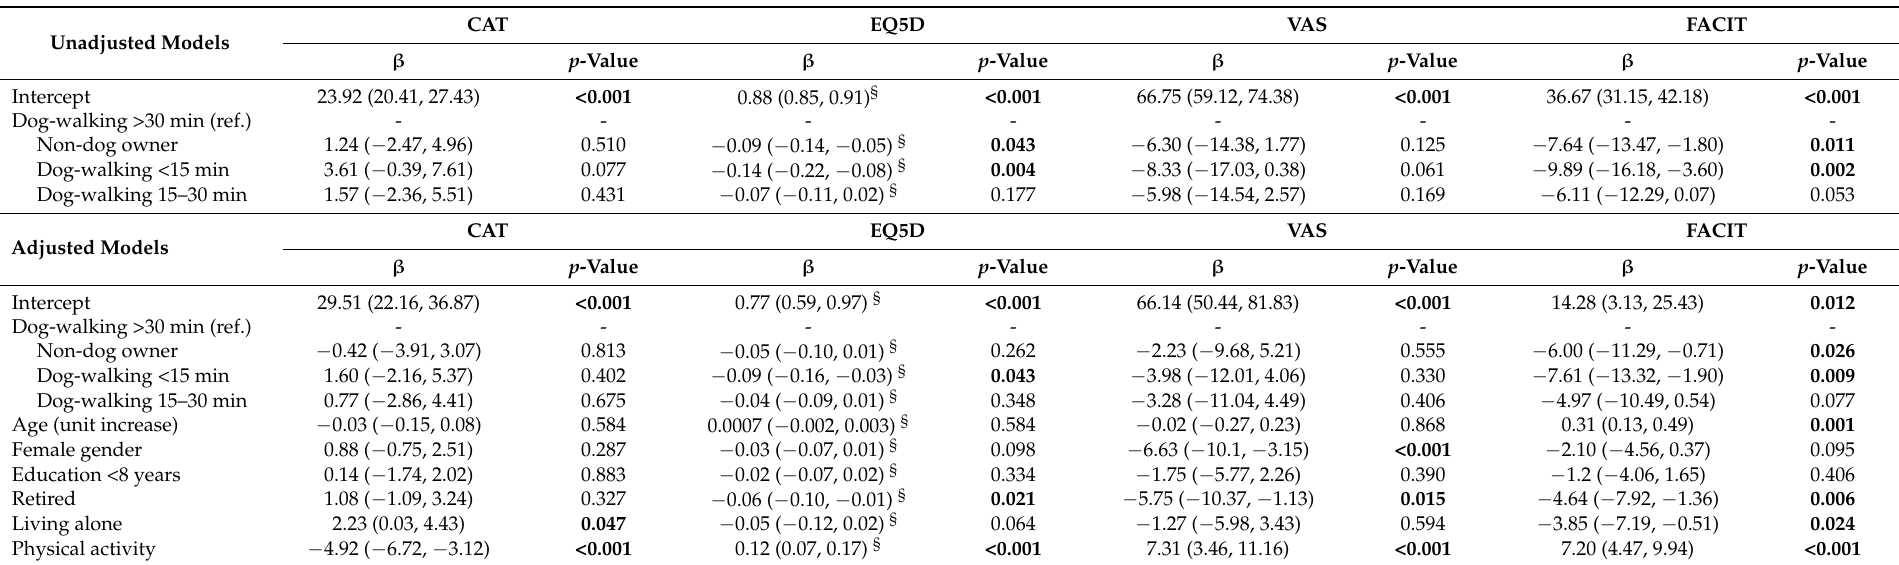
Table 3. Questionnaire scores: crude and adjusted β coefficients (mean differences) and 95% confidence intervals from linear regression models. Unadjusted